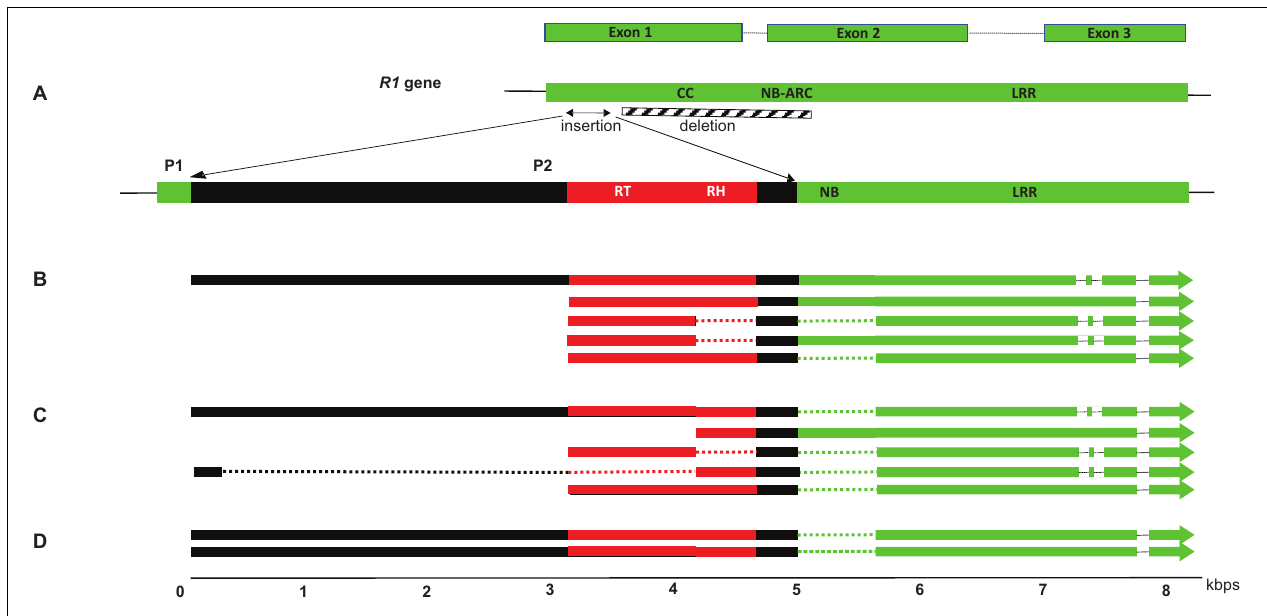
FIGURE 2 | Structure of the VR1 locus of S. melongena (A) and co-transcripts identified in S. incanum (B) , S. melongena (C) and S. insanum (D) . Viral and host sequences are shown in red and green, respectively. Spliced sequences in the co-transcripts are represented by dotted lines and the deletion at S. melongena VR1 locus is represented as a hatched box. The position of alternate promoters P1 and P2 are